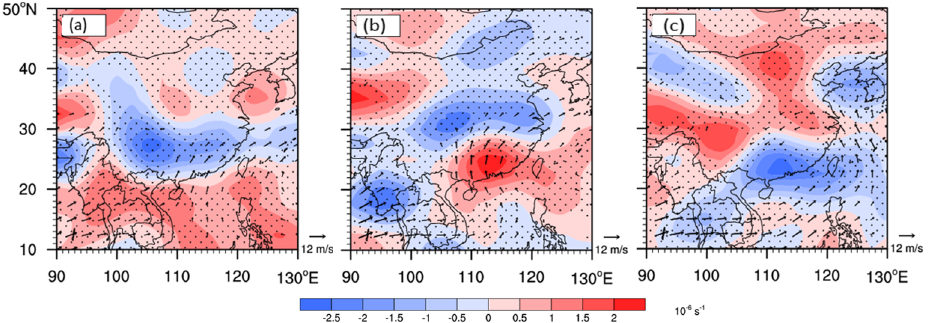
Figure 4. Composite anomaly winds and related divergence at 850 hPa for Mode1 ( a ), Mode2 ( b ), and Mode3 ( c ). (Arrows mean wind speed larger than 3 m/s; shaded areas are divergence, units: 10–6 s − 1 , dotted areas denote the t -test exceeding the confidence level of 0.05).